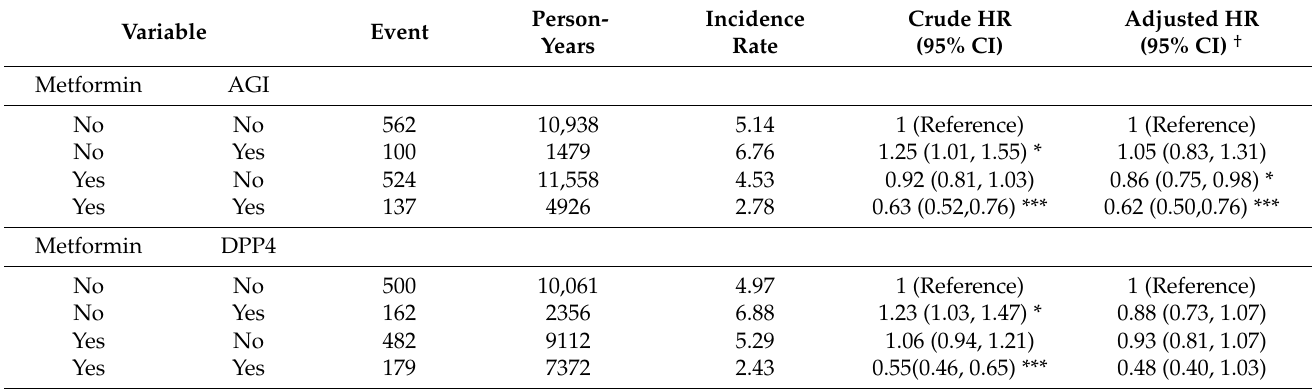
Table 4. Cox proportional hazard regression analysis for the risk of death due to nasopharyngeal cancer-associated metformin use with the combined effect of